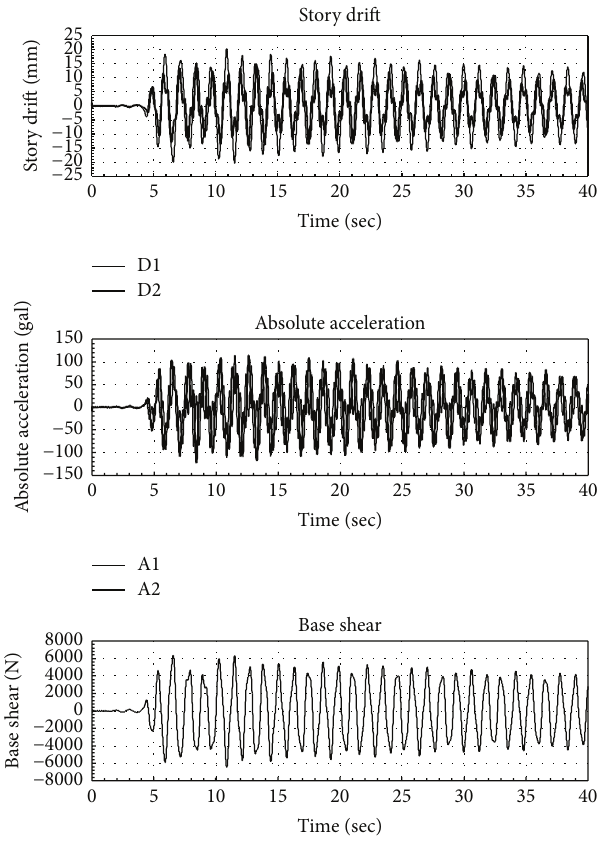
Figure 6: Time history of story drift, absolute acceleration, and base shear responses of bare structure under excitation of Kobe earthquake record with PGA = 0.50 m/sec 2 (50